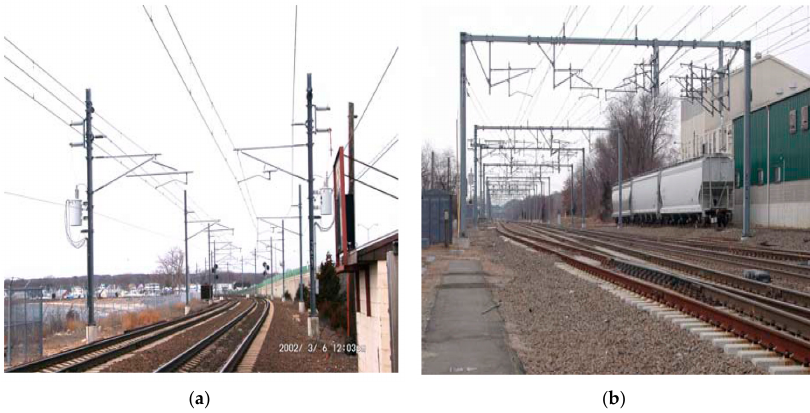
Figure 3. ( a ) Two track railway line; ( b ) Four track railway line.